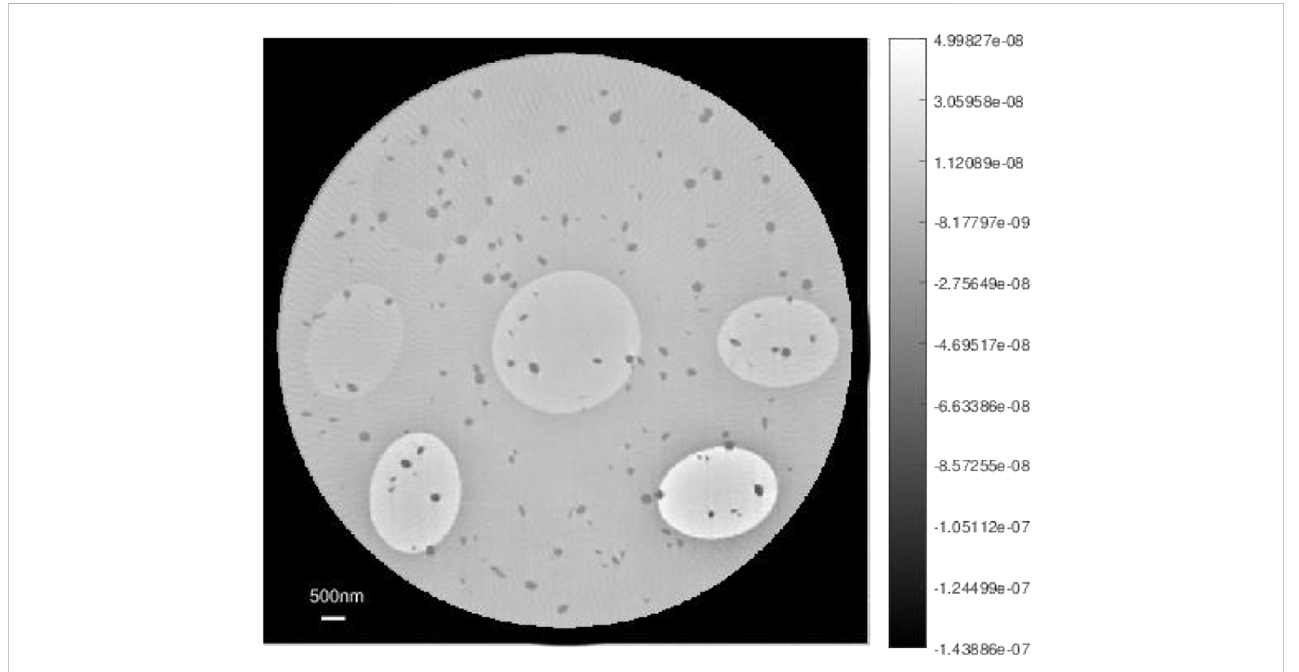
FIGURE 11 The inversion result using TFDM for noisy data with noise-level 1%.